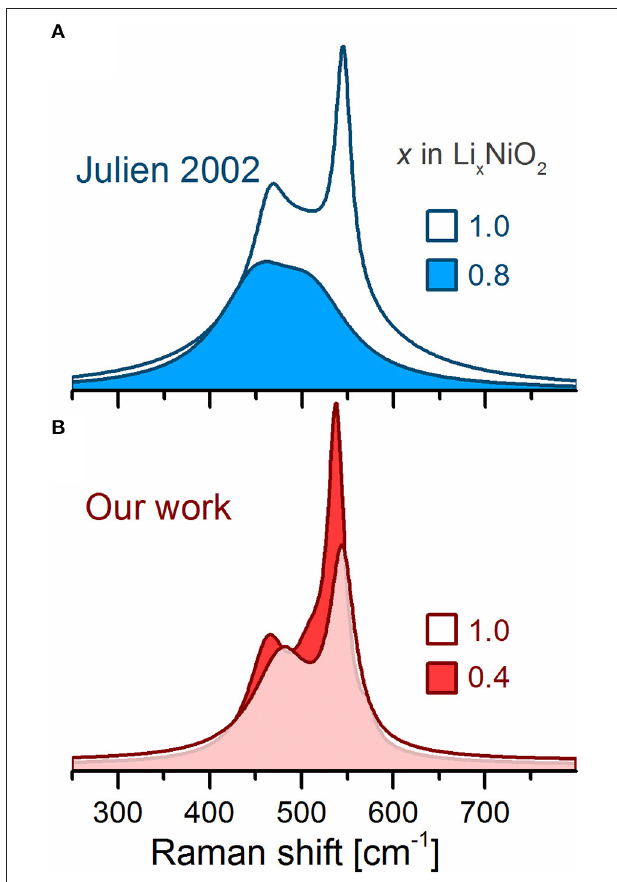
FIGURE 6 | Ex situ Raman spectra of electrochemically delithiated LiNiO 2 . (A) Spectra adapted from Julien (2002). (B) Our results.